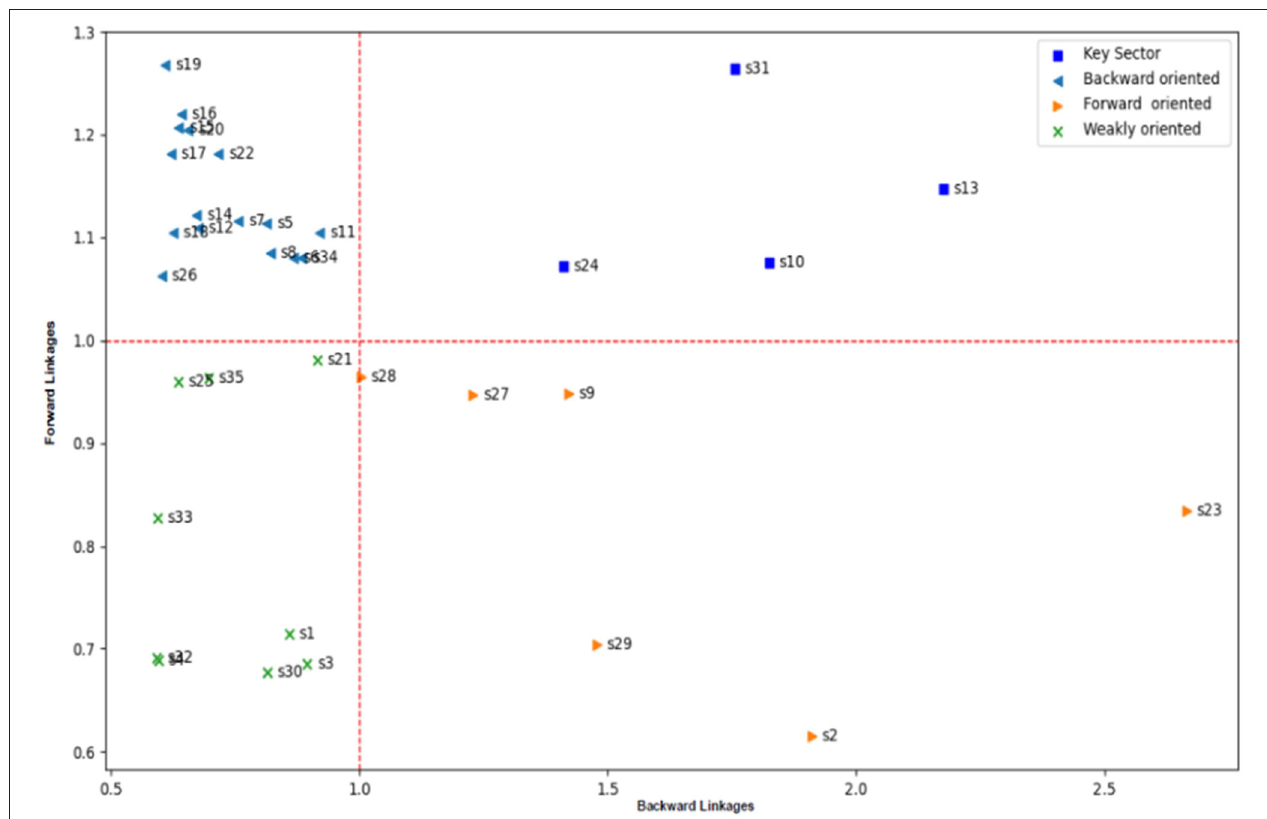
FIGURE 1 | Hirschman and Rasmussen backward linkages and forward linkages for the Saudi Arabia sector